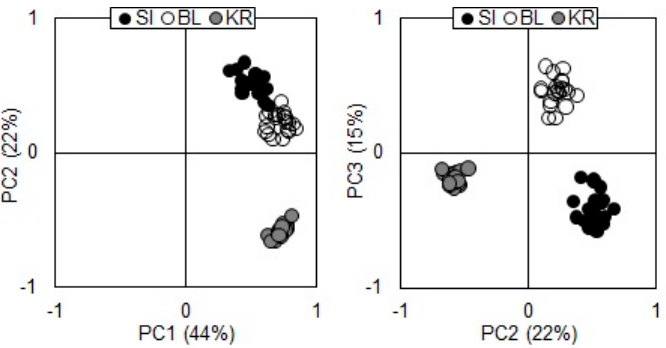
Figure 3. Grouping of the indexed chronologies of the larch provenances (see Figure 2b) in relation to the loadings of the principal components: PC1, PC2 and PC3. The parentheses provide the percentages of the total variances of the chronologies explained by their individual principal components.